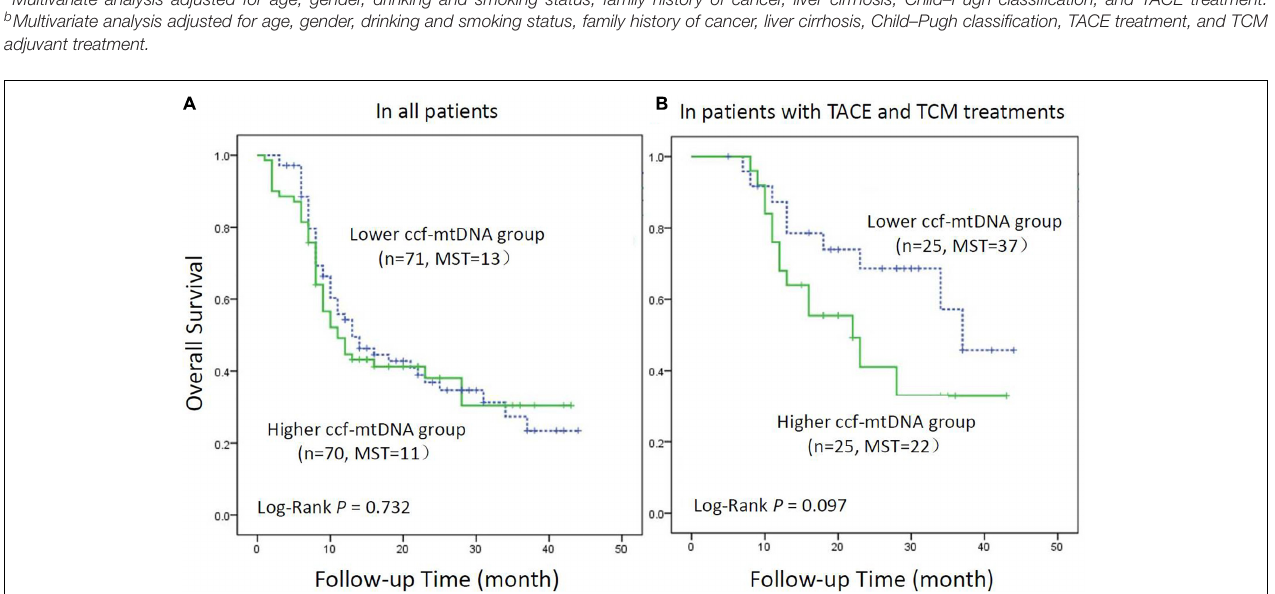
TABLE 2 | The association between ccf-mtDNA and overall survival of HBV-HCC patients. ccf- Number of Number of mtDNA patients deaths